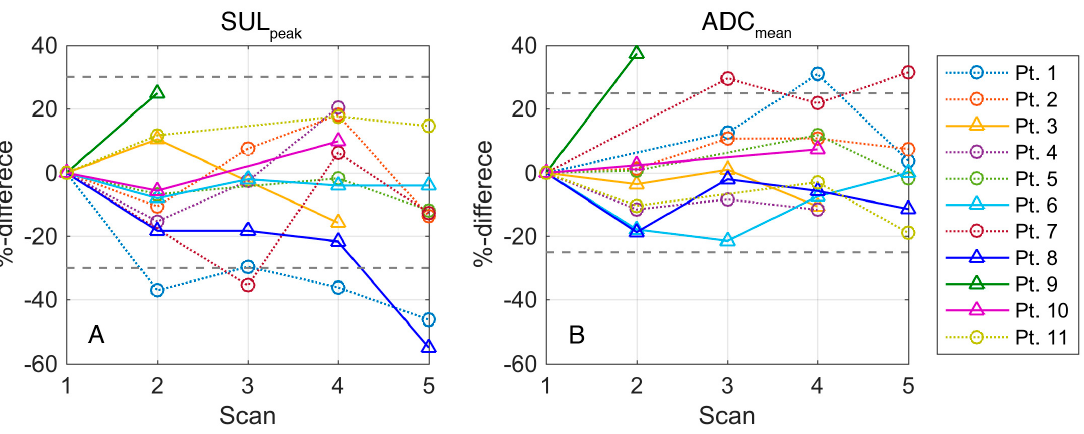
Figure 1. Changes in ( A ) FDG-uptake measured as SUL peak and ( B ) ADC median during the study period. Changes are presented for individual patients as percent difference with scan 1 as baseline. Dotted lines with circular markers indicate that the patient obtained stable disease or partial response (patient 1). Solid lines with triangular markers indicate patients with progressive disease.